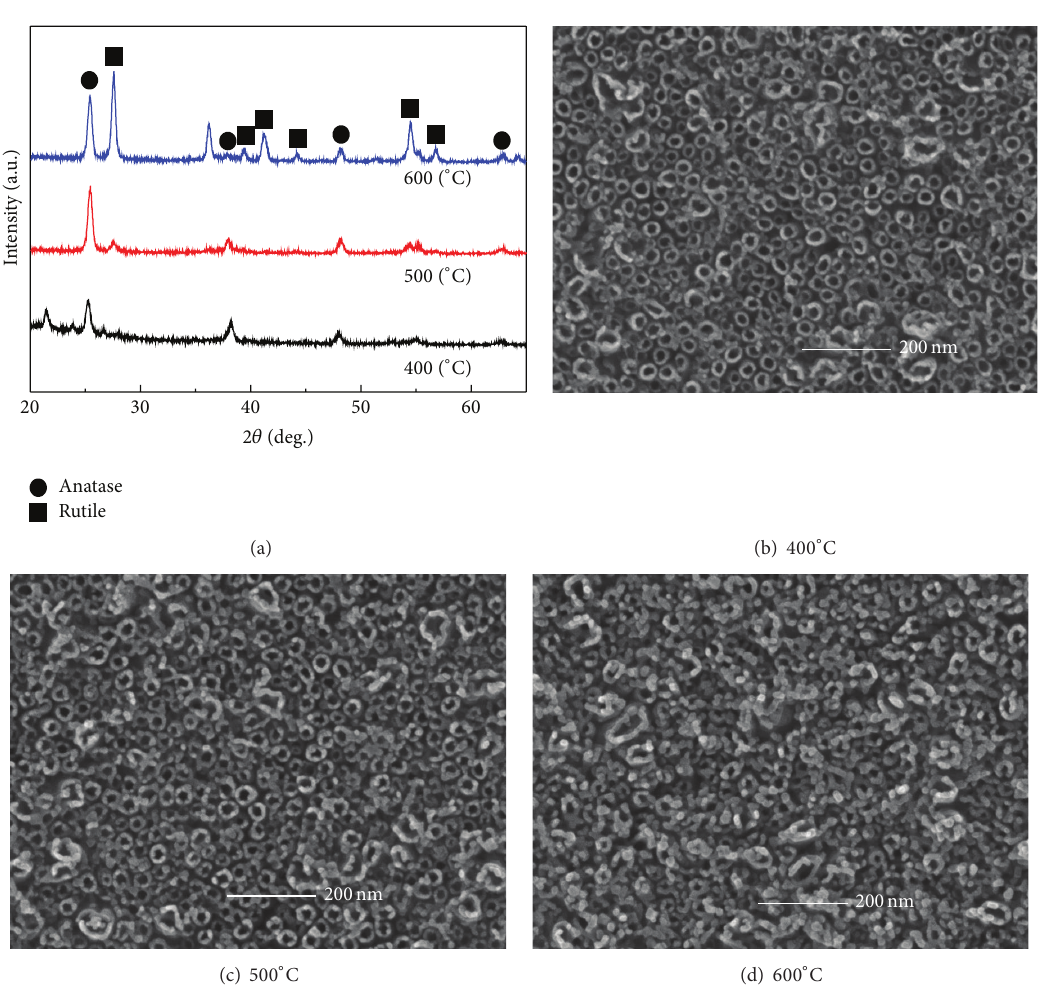
Figure 2: XRD patterns and surface SEM images of TNAs annealed at 400 ∘ C, 500 ∘ C, and 600 ∘